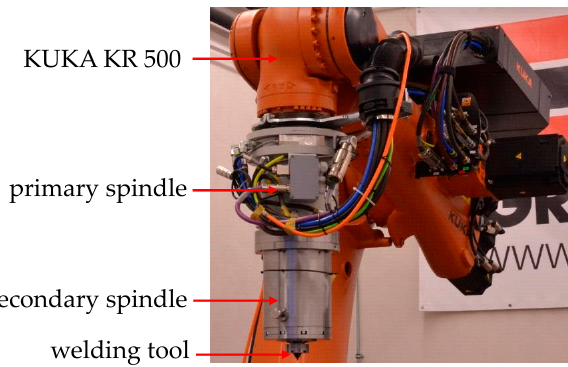
Figure 3. Robotized friction stir welding (FSW)-setup with double spindle construction and welding Figure3. Robotizedfrictionstirwelding(FSW)-setupwithdoublespindleconstructionandweldingtool. tool.